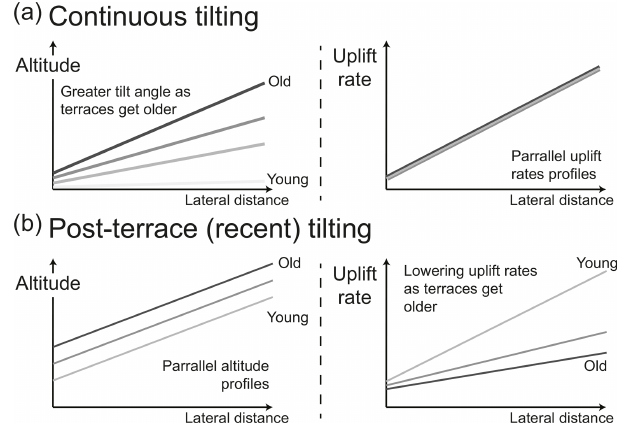
Figure 12. Terrace tilting scenarios. Expected shoreline angle al- titude and uplift profiles in the scenarios of (a) continuous tilting before and after terrace emplacement (as in Makran) and (b) re- cent tilting, after the youngest terrace emplacement (not observed in